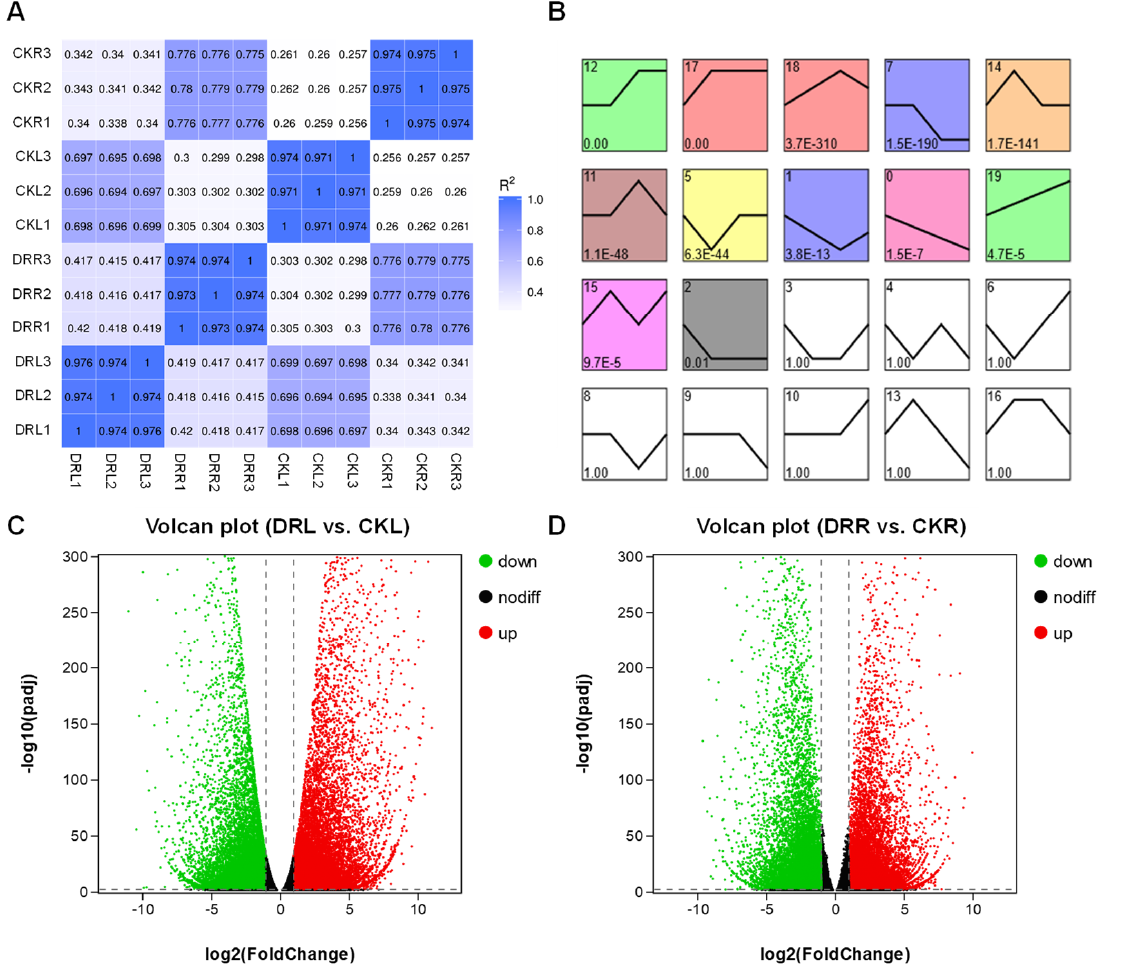
Figure 2. Differentially expressed genes in L. multiflorum leaves and roots under drought. ( A ) Pear- son correlation coefficients between all samples. CKL and CKR represent leaves and roots under normal control conditions, respectively. DRL and DRR represent leaves and roots under drought stress, respectively. ( B ) Profiles ordered based on the P-value of genes assigned versus expected results. ( C ) Volcano plot of DRL versus CKL. ( D ) Volcano plot of DRL versus CKL. Green represents down-regulated expression, red represents up-regulated expression, and black indicates no significant difference.